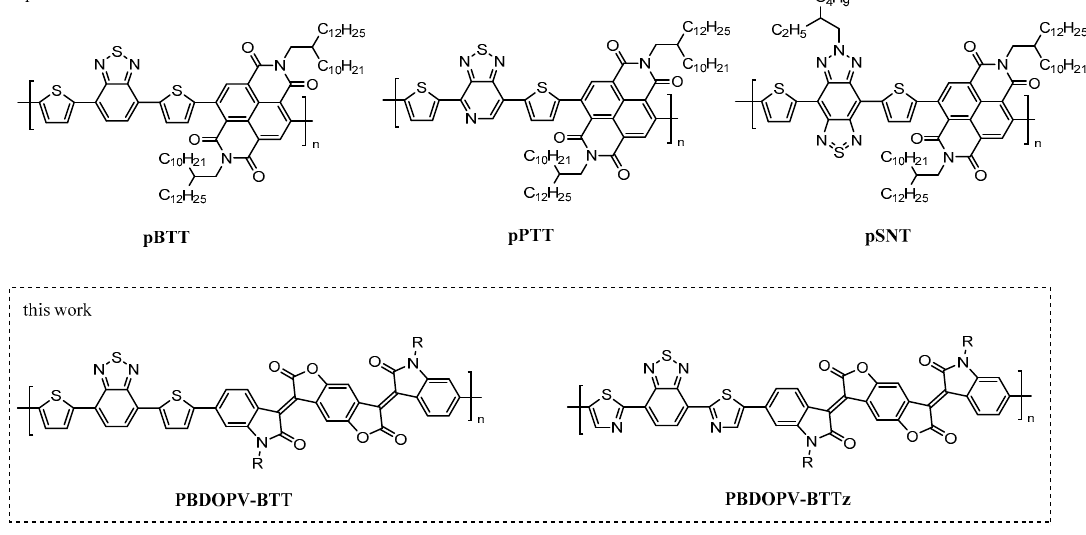
Figure 1. Chemical structures of high-performance naphthalenediimide (NDI)-based polymers and benzodifurandione-based oligo( p -phenylenevinylene) (BDOPV)-based polymers.